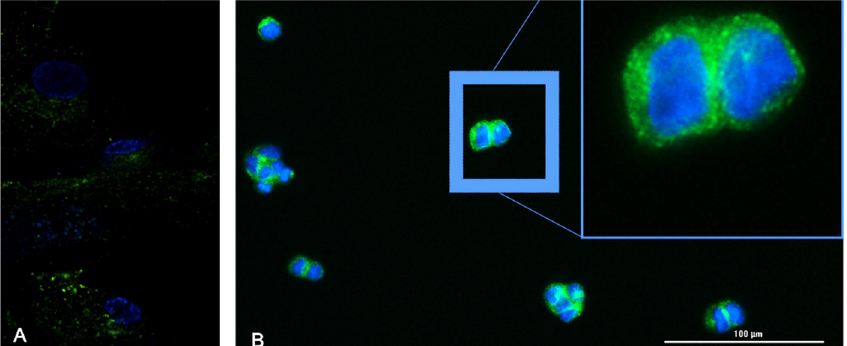
Figure 4. TfR1 is present to a greater extent throughout the plasmatic membrane of H69AR ( B ) than in MRC5 ( A ) cell line. Indirect immunofluorescence image of TfR1 protein labeled with anti CD71 as a primary antibody, 1:500 incubated overnight and the secondary goat anti-mouse-FITC, 1:750 was incubated for 1 h at room temperature.